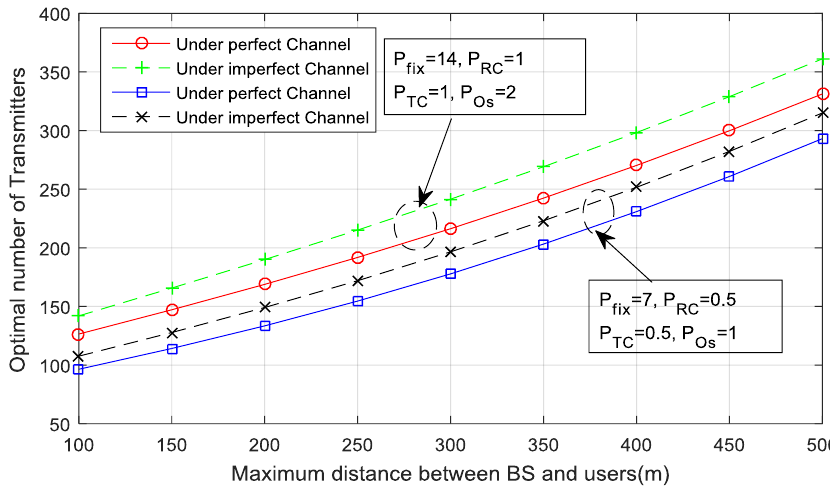
Figure 6. Optimal number of transmitters at different area of coverages.